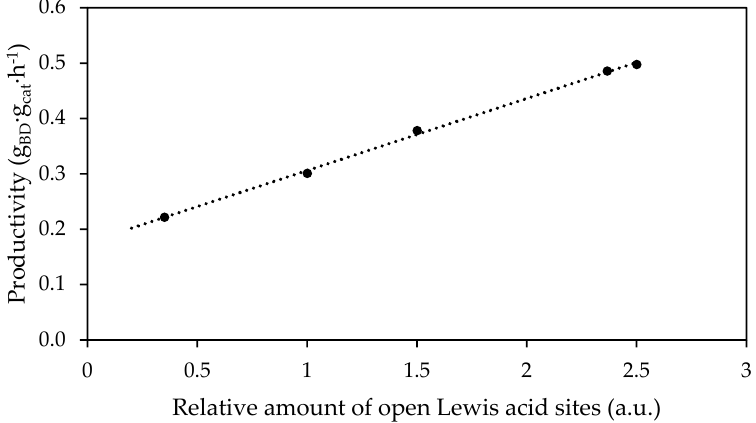
Figure 10. Correlation between the relative amount of open Lewis acid Zr sites with the rate of BD formation. Adapted from [32]. Copyright 2016, WILEY-VCH Verlag GmbH & Co. KGaA.